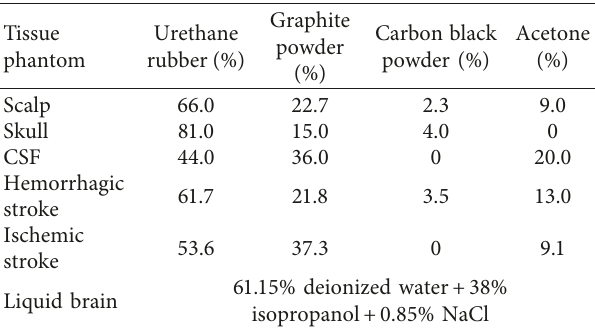
Table 3: Weight percentages of phantom materials for fabrication of a multilayer human head phantom for stroke detection.